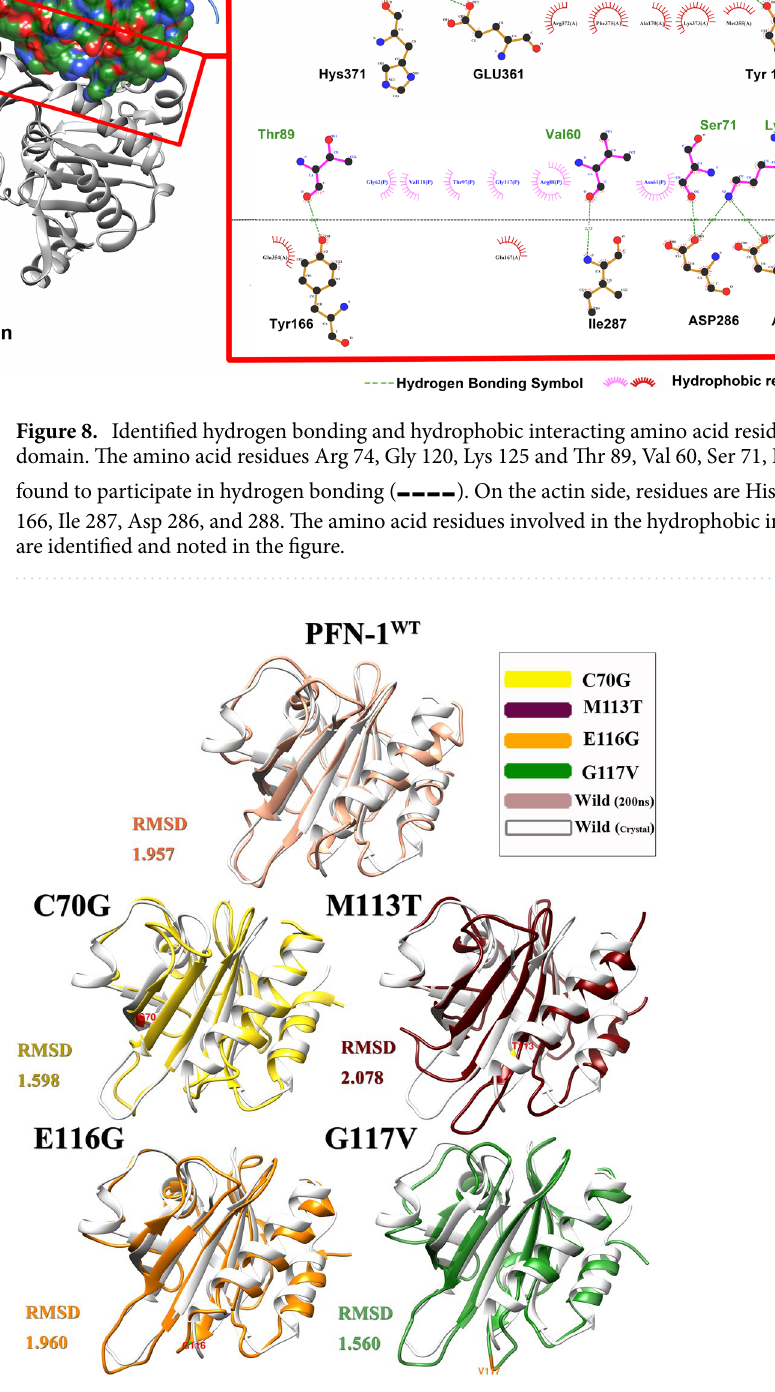
Figure 9. Superimposition of PFN-1 WT (white) over the mutant structures (the predefined colors) after 200 ns MD simulation. In this case with RMSD 1.957 which is related to the wild structure of PFN-1 before and after 200 ns MD simulation, The RMSD of M113T mutations with a value of 2.078 is larger than the PFN-1 WT structure and the C70G and G117V mutations with a value of 1.560 and 1.598 respectively, are less than the PFN-1 WT , while RMSD value for E116G is almost equal to the PFN-1 WT